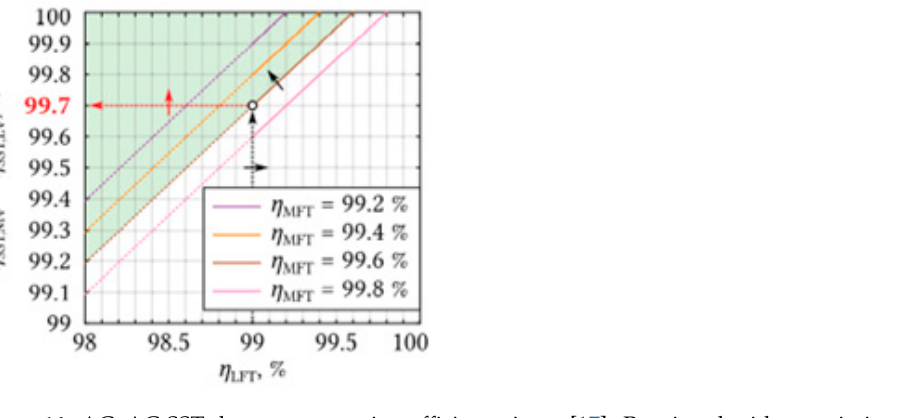
Figure 14. AC–AC SSTs have a conversion efficiency issue [17]. Reprinted with permission from Ref. [15]. 2022, IEEE.